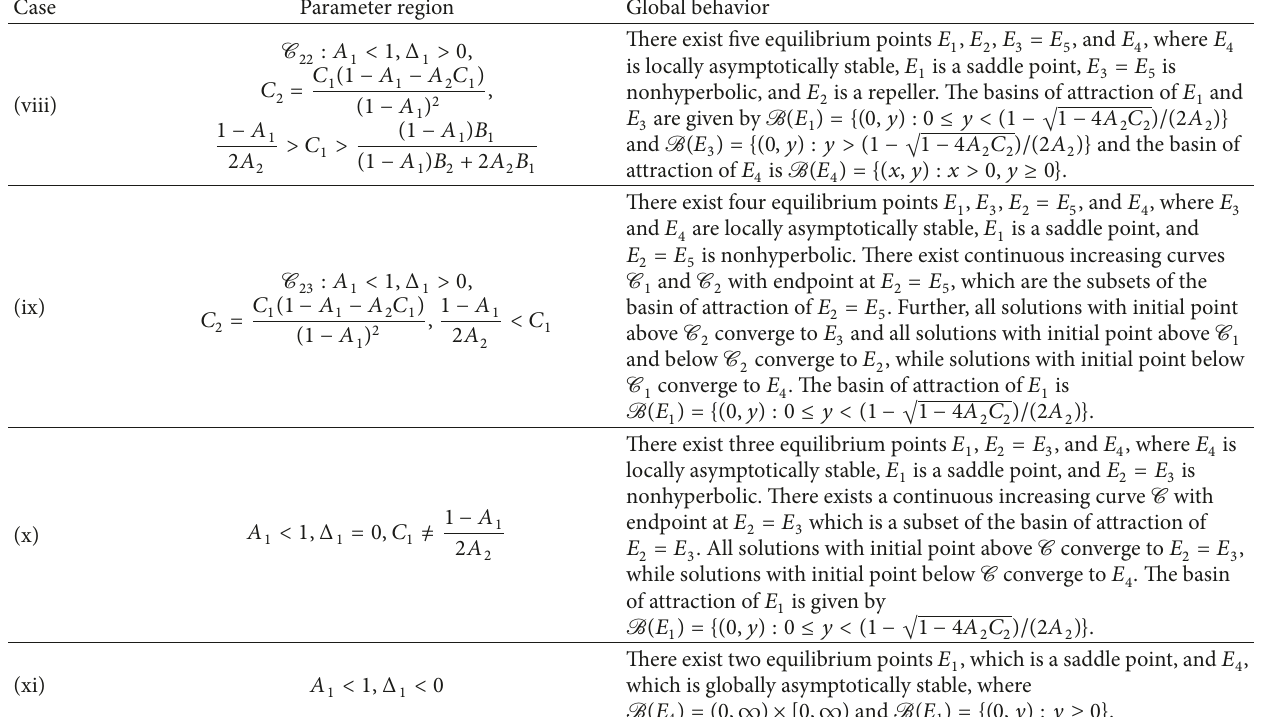
= 𝐸 𝐸 𝐸 1 4 is nonhyperbolic, 3 is locally asymptotically stable, and 2 is a saddle point. The stable manifold W 𝑠 (𝐸 2 ) of the saddle point 𝐸 2 is an increasing separatrix with endpoint at 𝐸 2 , and solutions with initial point above W 𝑠 (𝐸 2 ) converge to 𝐸 3 , while solutions with initial point below W 𝑠 (𝐸 2 ) converge to 𝐸 4 . All orbits that start on W 𝑠 (𝐸 2 ) are attracted to 𝐸 2 . The basin of attraction of 𝐸 1 is given by B (𝐸 There exist two equilibrium points 𝐸 1 = 𝐸 4 and 𝐸 2 = 𝐸 3 which are nonhyperbolic. There exists a continuous increasing curve C with endpoint at 𝐸 2 = 𝐸 3 which is a subset of the basin of attraction of 𝐸 = 𝐸 C converge to 𝐸 = 𝐸 2 3 . All solutions with initial point above 2 3 , while solutions with initial point below C converge to 𝐸 1 = 𝐸 4 .